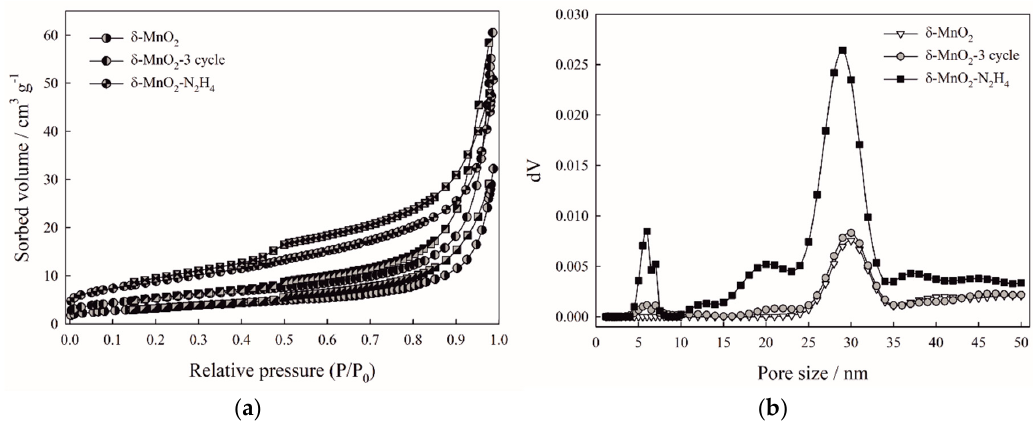
Figure 3. Nitrogen sorption isotherms ( a ) and pore size distributions ( b ) of the studied birnessites.